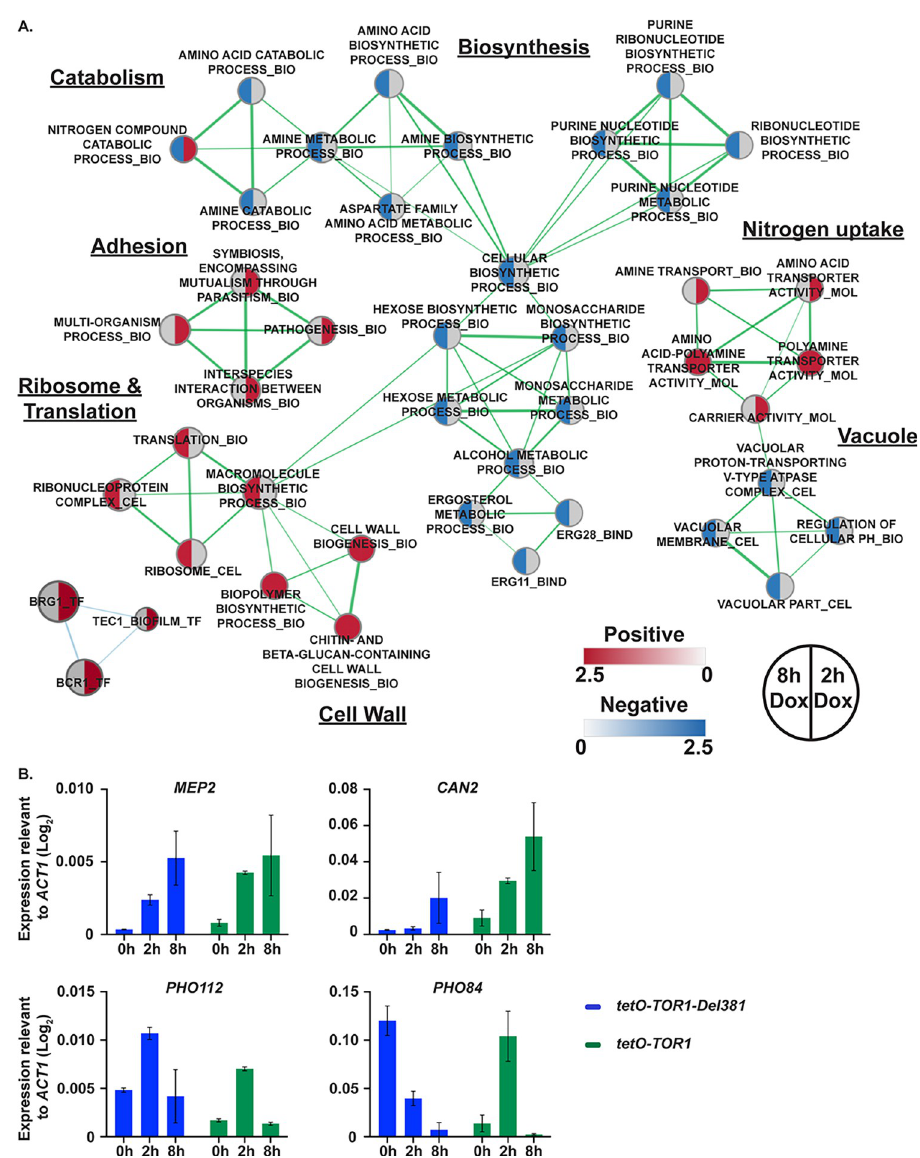
Fig 10. Classic TORC1-regulated gene sets were dysregulated during TOR1 repression in FL cells. A. Enrichment map showing the major categories of genes identified by Gene Set Enrichment Analysis (GSEA) in the transcript profiles of tor1/tetO-TOR1 (JKC1549) cells repressed in 30 mg/ml doxycycline for 2 h or 8 h in YPD compared to tor1 / TOR1 (JKC1347). Nodes represent gene sets (FDR q < 0.1) where color intensity reflects the Normalized Enrichment Score (NES) and node size reflects the number of enriched genes. Grey color indicates category was not significantly enriched under this experimental condition. Width of connecting lines (edges) indicates the degree of overlap between categories. B. MEP2 , CAN2 , PHO112 and PHO84 gene expression quantification relative to ACT1 expression, after repressive (30 mg/ml) 2h and 8h doxycycline treatment in tor1/tetO-TOR1-Del381 ( tetO-TOR1-Del381 , JKC1441) and tor1/tetO-TOR1 ( tetO-TOR1 , JKC1549)